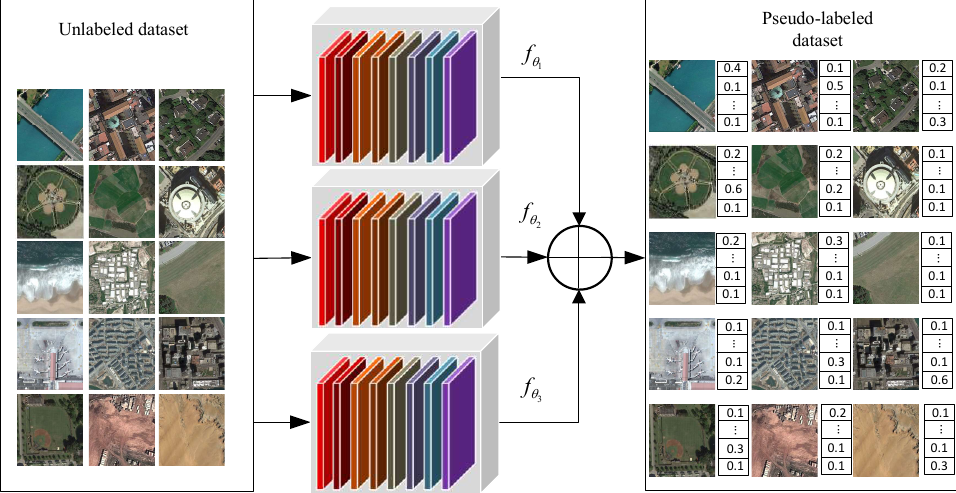
Figure 2. Framework of unlabeled sample labeling with early training